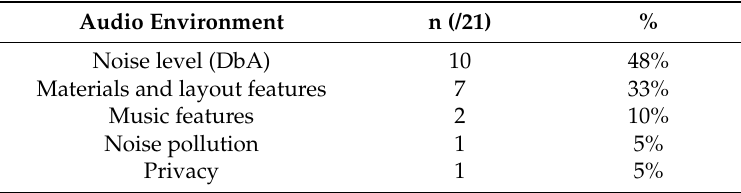
Table 10. Number and percentage of indicators grouped according to Audio environment